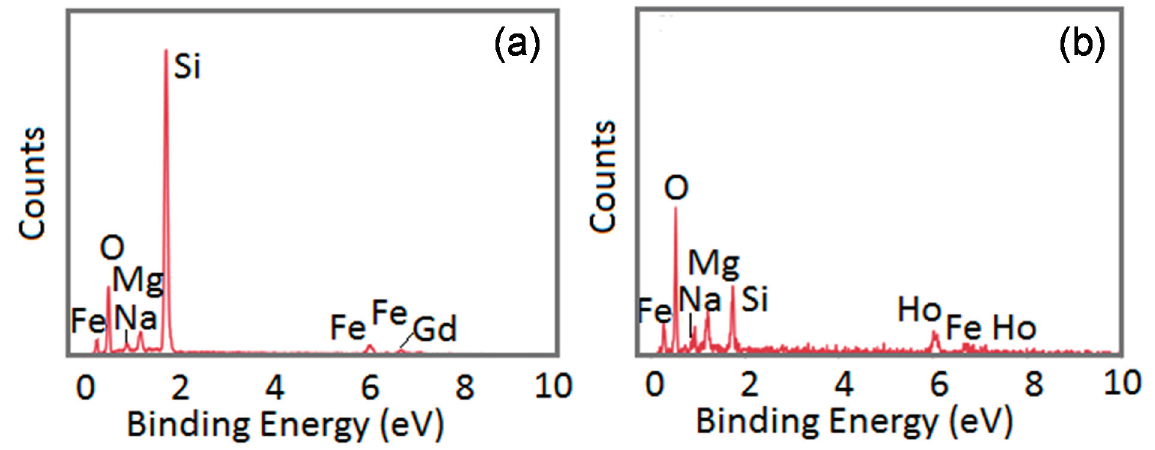
Figure 6. SEM/EDX analysis of the enzymatically-synthesized ( a ) Fe 45±14 Gd 5±2 O 50±15 and ( b ) Fe 42±4 Ho 6±4 O 52±5 magnetic